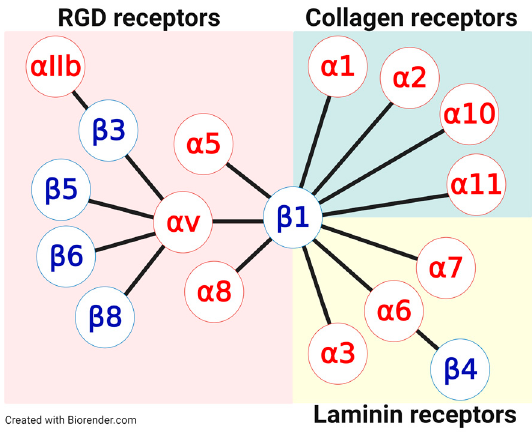
Figure 1. The extracellular matrix (ECM) protein binding integrin family and its classification into subfamilies. The classification is based on the binding specificity of these subfamilies toward ECM proteins. In higher vertebrates, 18 α and 8 β subunits were discovered, forming 24 different integrins through non-covalent interactions. Sixteen of these integrins bind ECM proteins. The leukocyte integrins, cell surface adhesion molecules, are excluded as they are not involved in ECM protein binding but in cell–cell interactions.